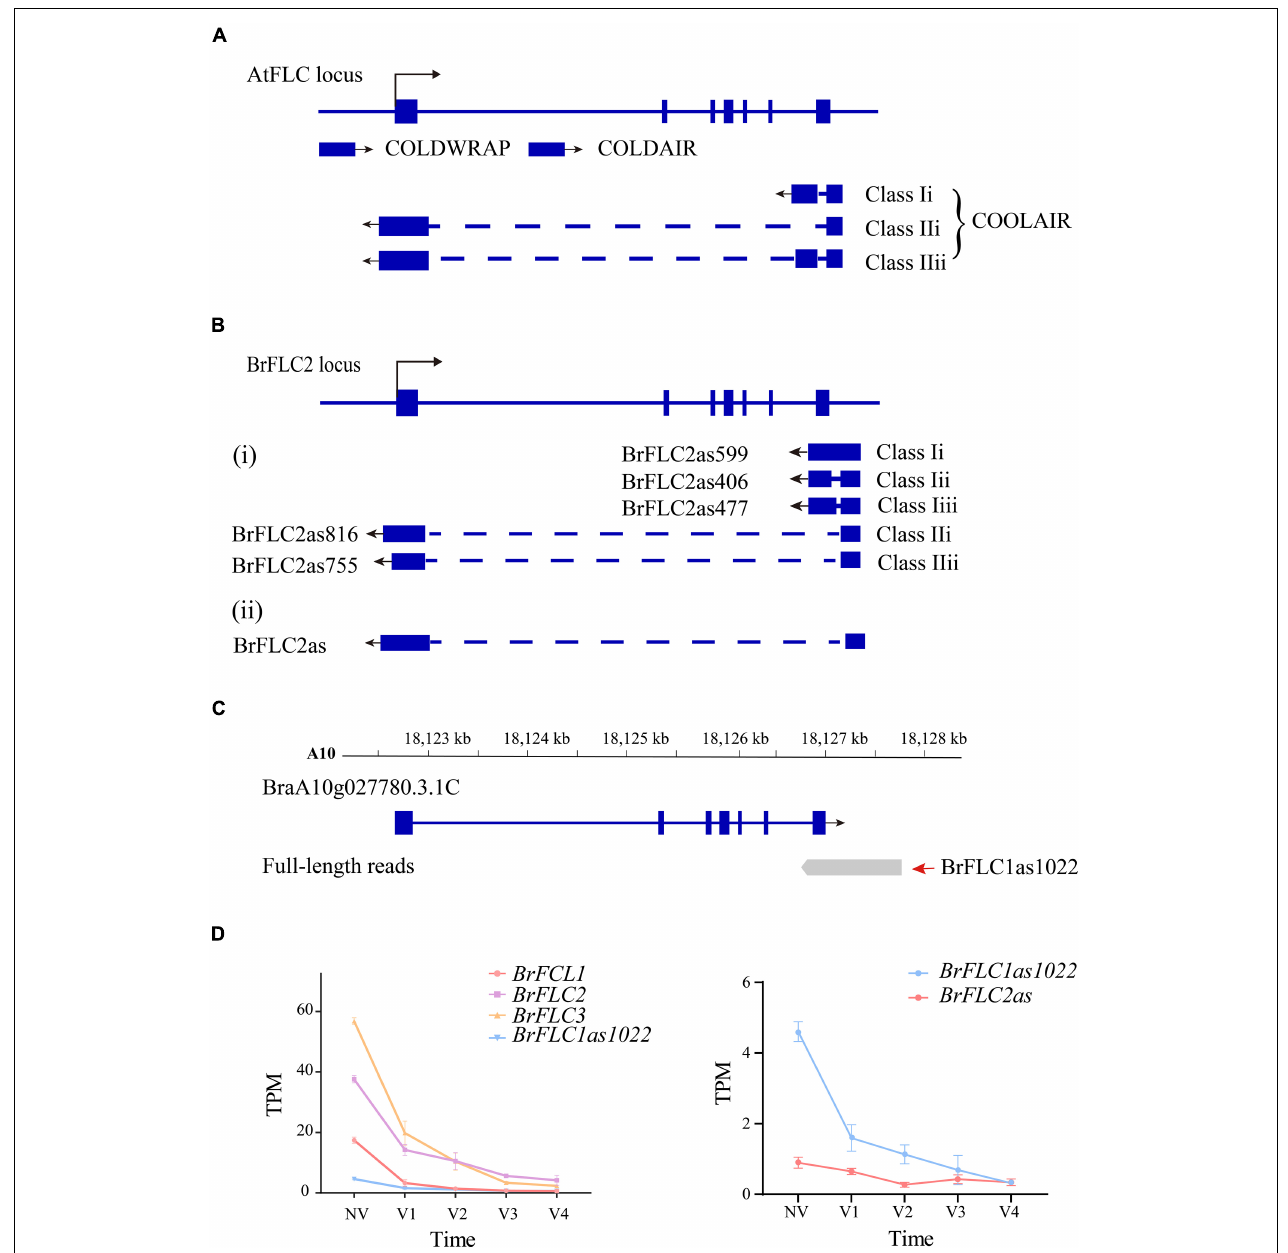
FIGURE 7 | LncRNA identification in Iso-seq data (A) AtFLC gene regulation by lncRNAs. COOLAIR is alternatively spliced. Class I and class II are abundant COOLAIR isoforms. The blue boxes indicate gene exons. The full line indicates chromosome. The dotted line indicates introns. The arrow mark indicates the direction of transcription. (B) BrFLC2 gene regulation by COOLAIR in the previous studies. (C) The gene structure of BrFLC1 in previous annotation and full-length transcript. The first of read is PB.25365.1 . The second of read is PB.25365.2 ( BrFLC1as1022 ). (D) The line chart depicts the expression trend of BrFLCs , BrFLC1as1022 and BrFLC2as during